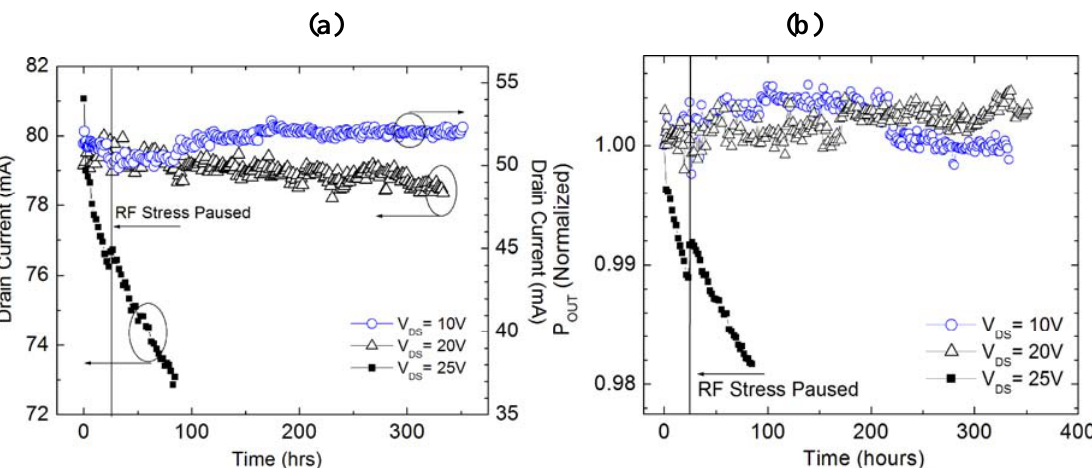
Figure 9. ( a ) Drain current and ( b ) output power during RF stress at 10 GHz under 3 dB compression of 0.125 µm gate length AlGaN/GaN HEMT. Reprinted with permission from [61]. Copyright 2011 Electrochemical